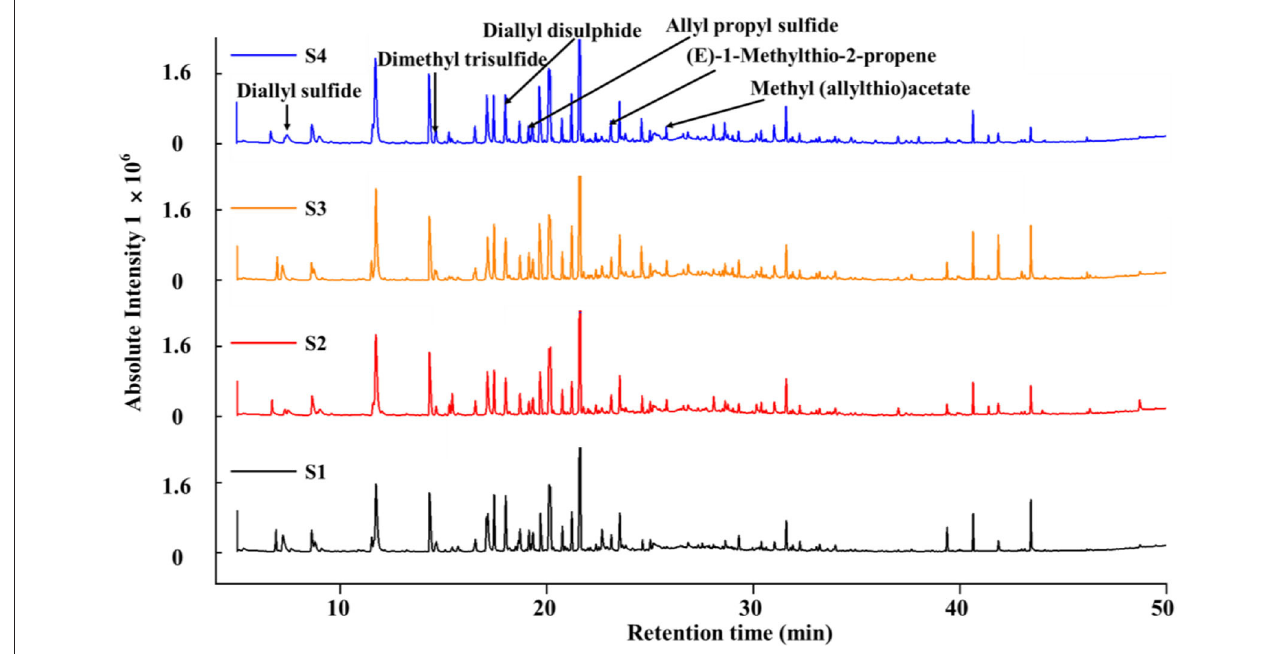
FIGURE 6 | Gas chromatography–mass spectrometry (GC-MS) profiles of volatile compounds in black garlic fermentation